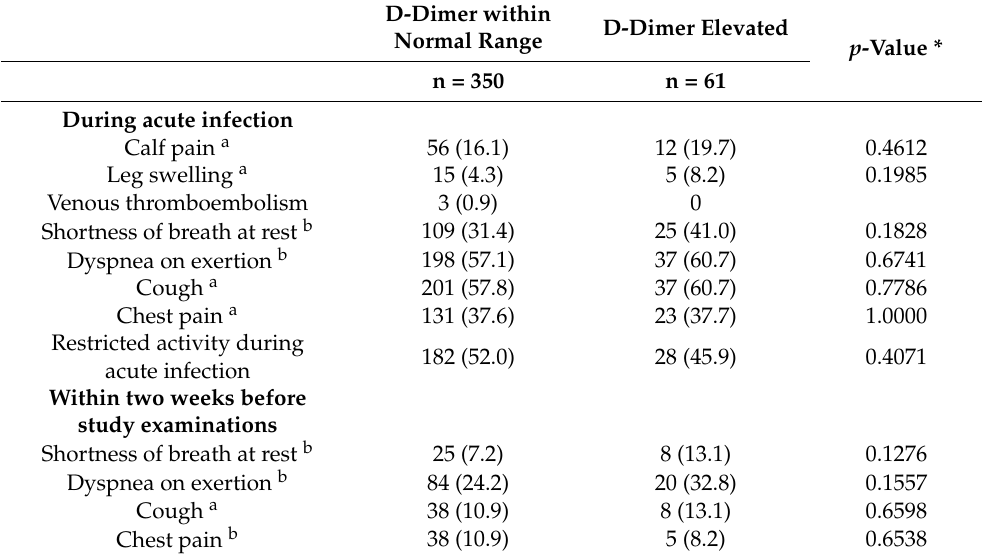
Table 2. Selected symptoms and complaints during the acute COVID-19 infection and within two weeks before study participation in subjects with and without elevated plasma D-dimer concentrations.